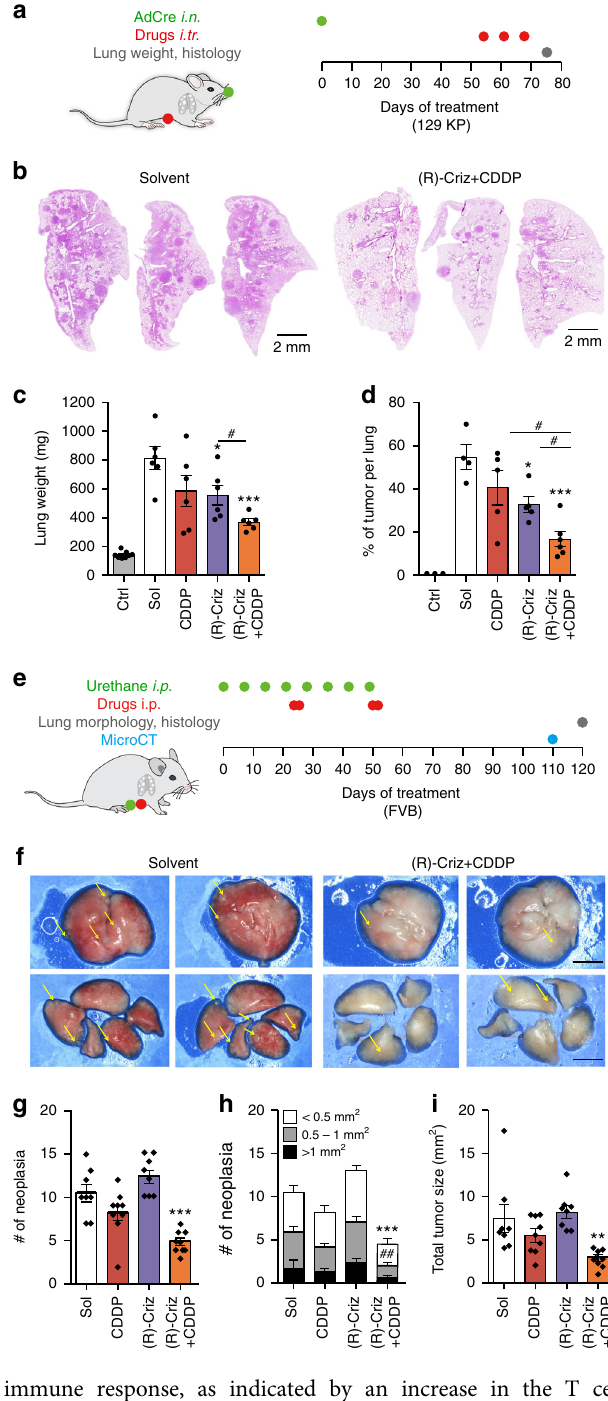
tumor sizes ( i ) are reported. Results are expressed as mean